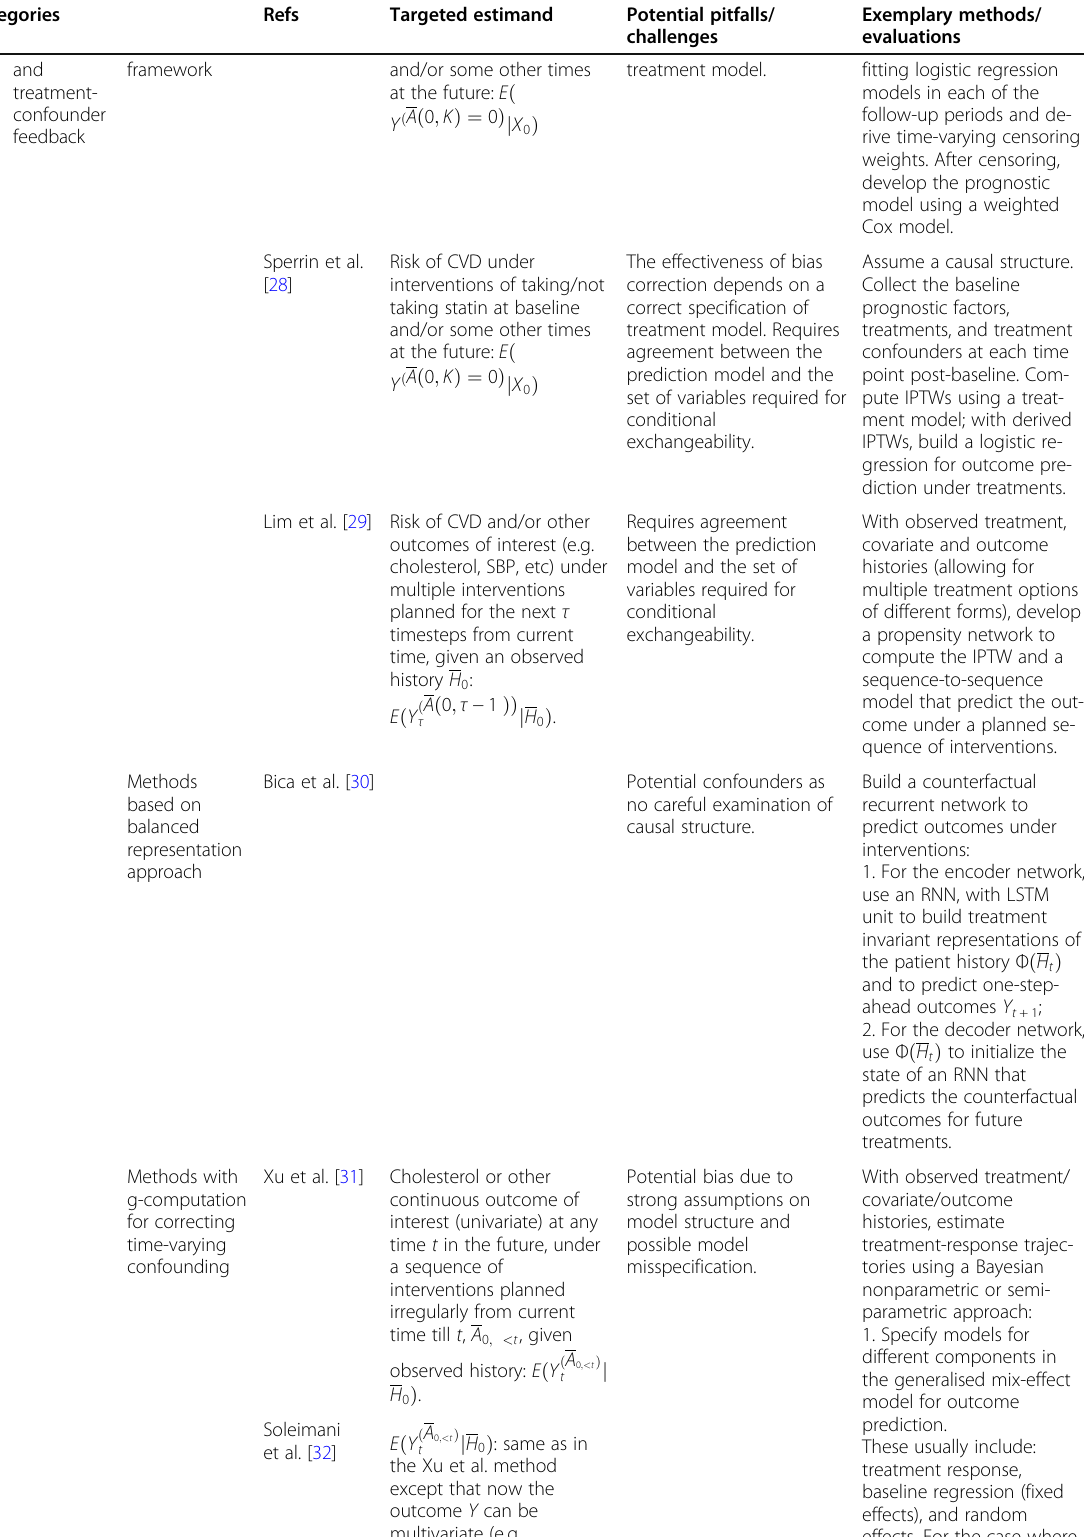
Table 2 Illustration of methods in different categories using an example of statin intervention in primary prevention of CVD (Continued) Approach